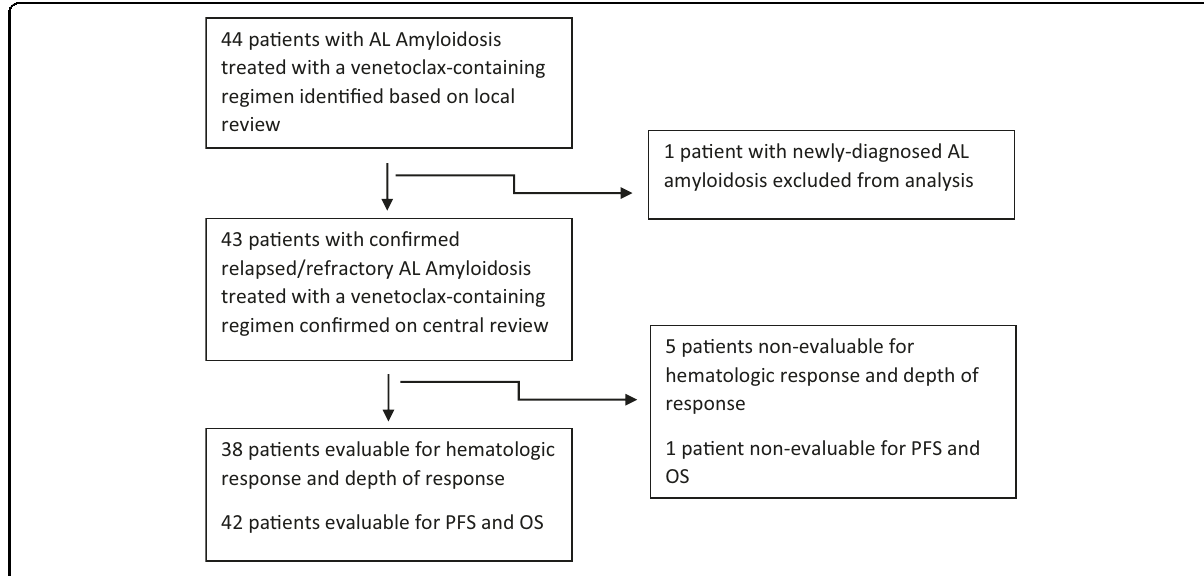
Fig. 1 Study pro fi le. Study pro fi le for included